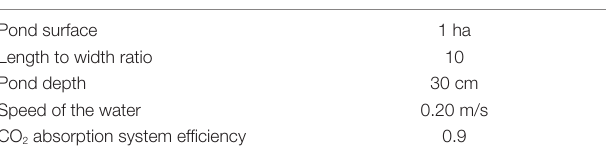
TaBle 1 | Open pond characteristics.